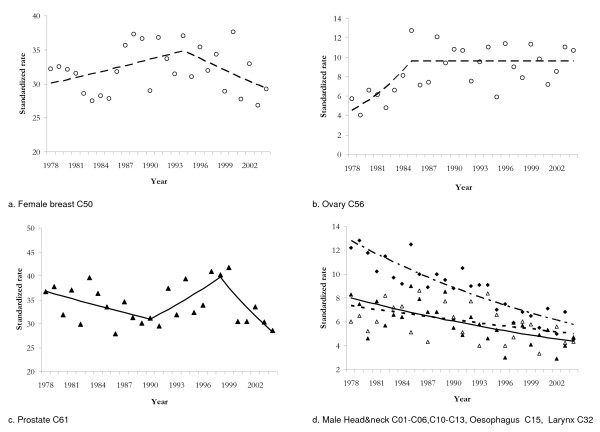
Observed standardized mortality rates per 100.000 inhabitants and 'best' joinpoint model estimates for female breast, ovary, prostate, male head and neck (▲ observed; solid line joinpoint), oesophagus (△ observed; dotted line joinpoint) and larynx cancers (◆ observed; mixed line joinpoint).